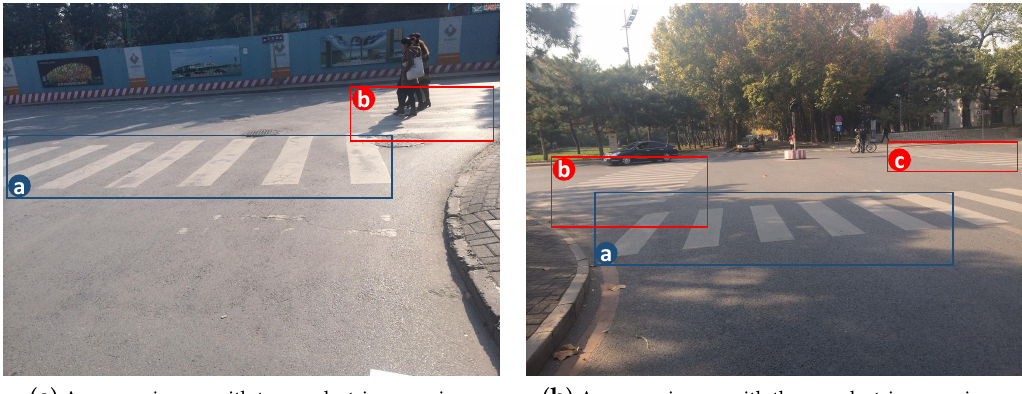
Figure 1. Existing methods focus on detecting the pedestrian crossing immediately in front of the camera (indicated by the blue rectangle), while leaving the other undetected (indicated by the red